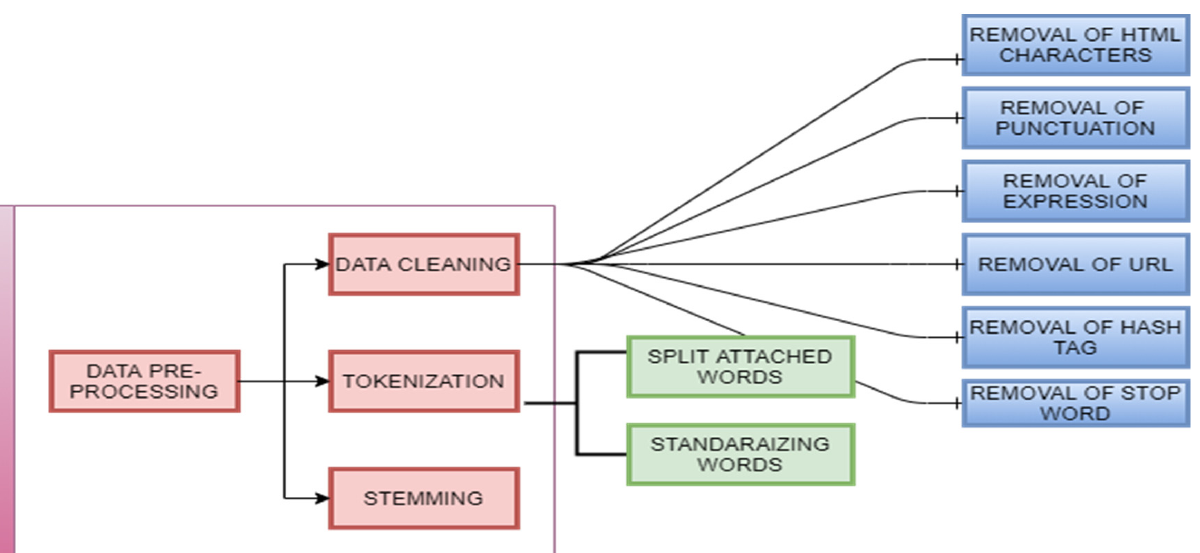
Table 1. Example for scoring the sentiment polarity by VADER.